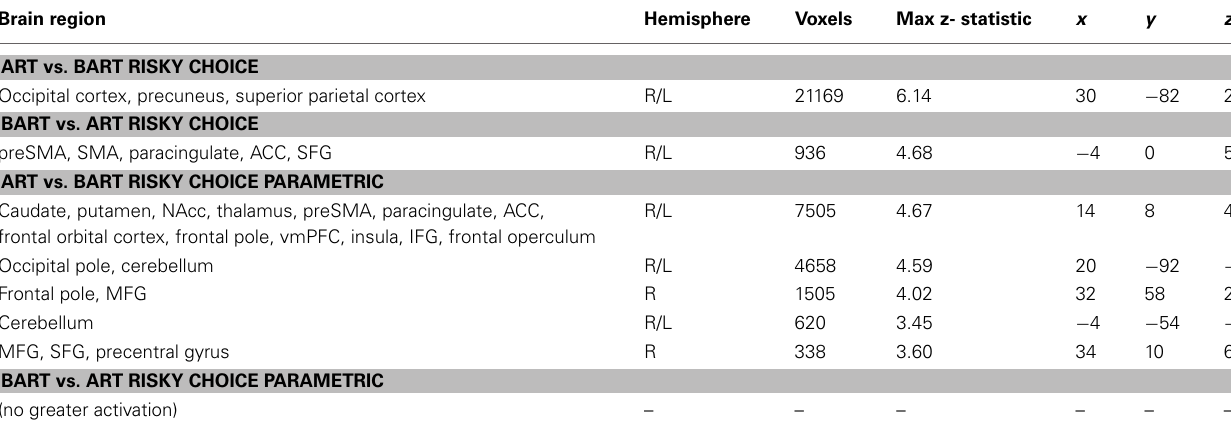
Table 3 | Contrasts between ART and BART tasks.